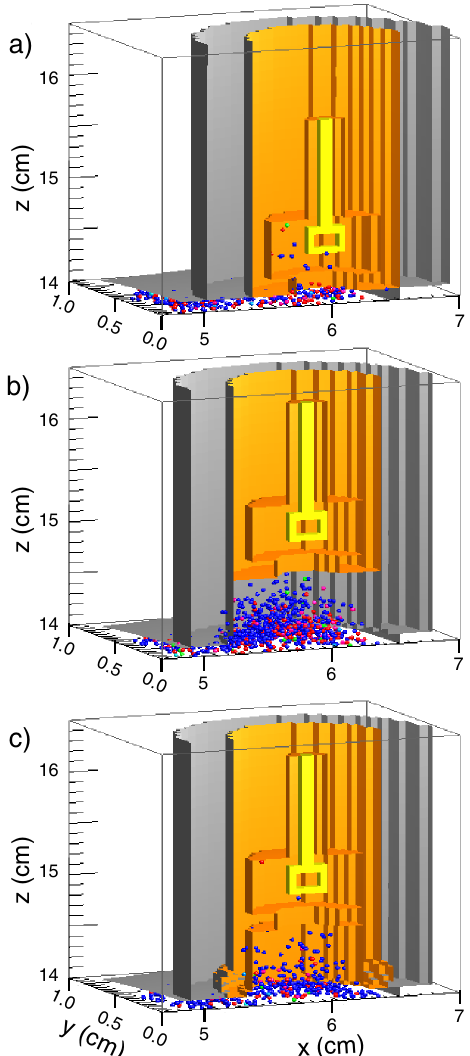
FIG. 5. (Color) Sample particle positions after t ¼ 30 ns in simulations of the (a) original inner-MITL B -dot probe configu- ration, (b) the best design, and (c) the final design. The electron macroparticles are colored according to their origin as described in the text.